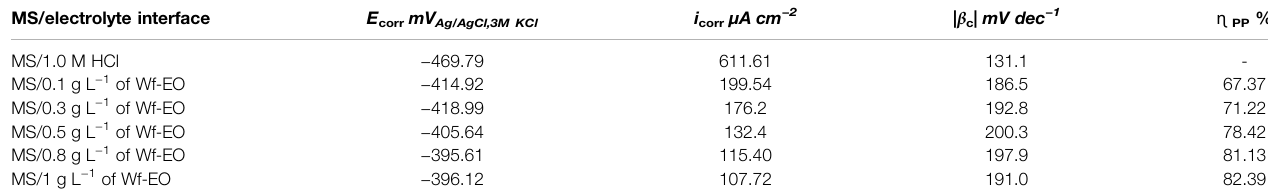
TABLE 2 | Electrochemical parameters generated from PP curves of MS immersed in 1.0 M HCl at different concentrations of Wf-EO at 298 K. MS/electrolyte interface